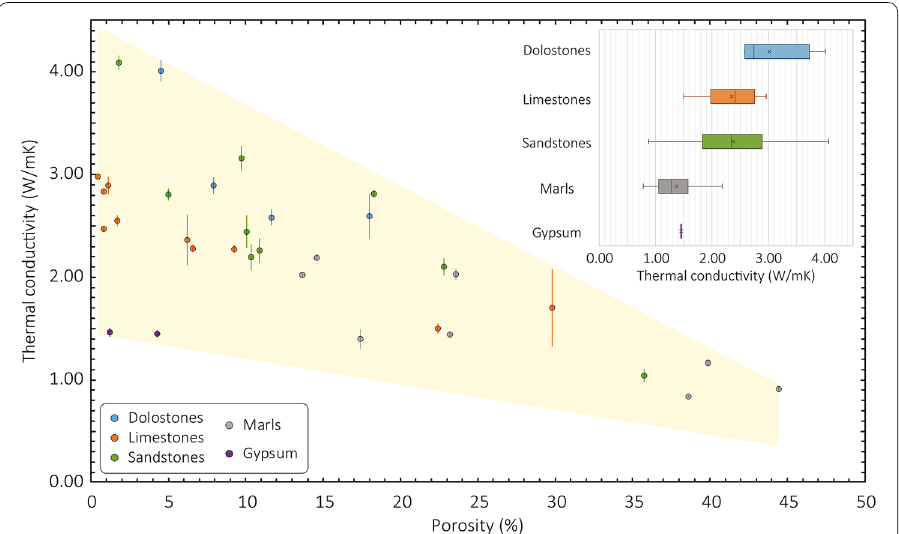
Fig. 6 Box and whisker plots of thermal conductivity ranges for the various lithologies, measurements on samples in the dry state at ambient temperature. Thermal conductivity of samples in the dry state at ambient temperature as a function of porosity. Error bars are the standard deviations of thermal conductivities. The yellow polygon indicates the general trend of evolution of conductivity as a function of